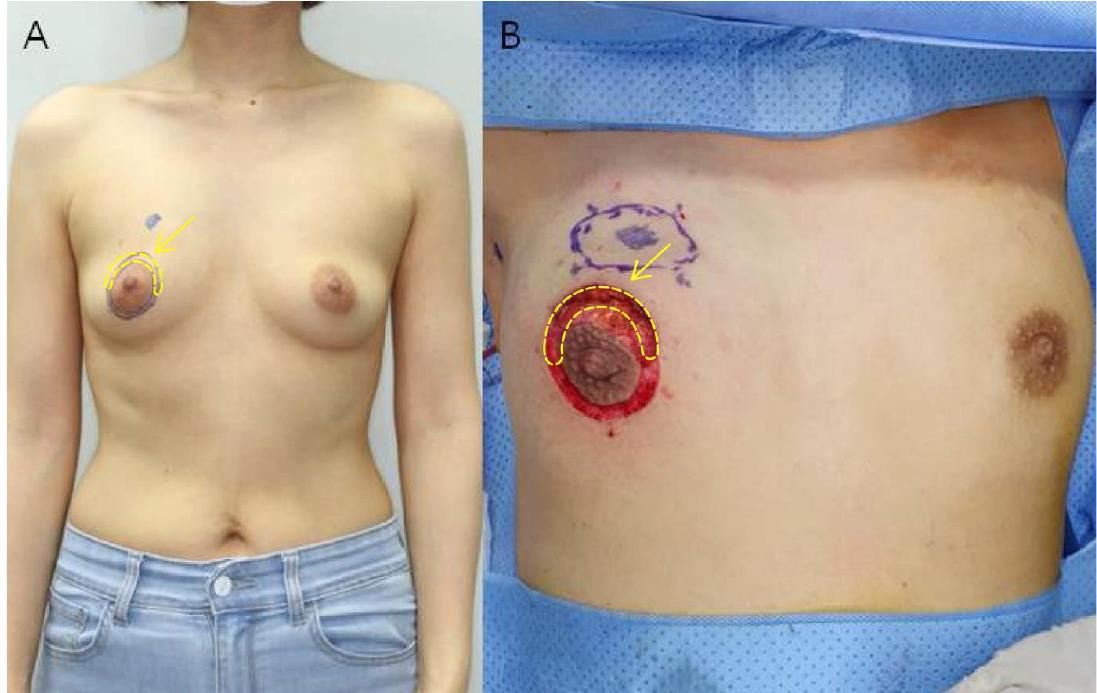
Figure 1. ( A ) Preoperative photograph of a 46-year-old woman. The tumor is located in the upper inner quadrant of the right breast. After drawing two concentric circles centered on the nipple, a semicircular incision is made along the arc of the breast cancer site to perform breast conservation surgery. ( B ) Intraoperative photograph after tumor resection. Deep dissection is performed between the two concentric circles and the semicircular part of the breast cancer site is excised. Excess skin was excised to obtain the specimen (yellow arrow).